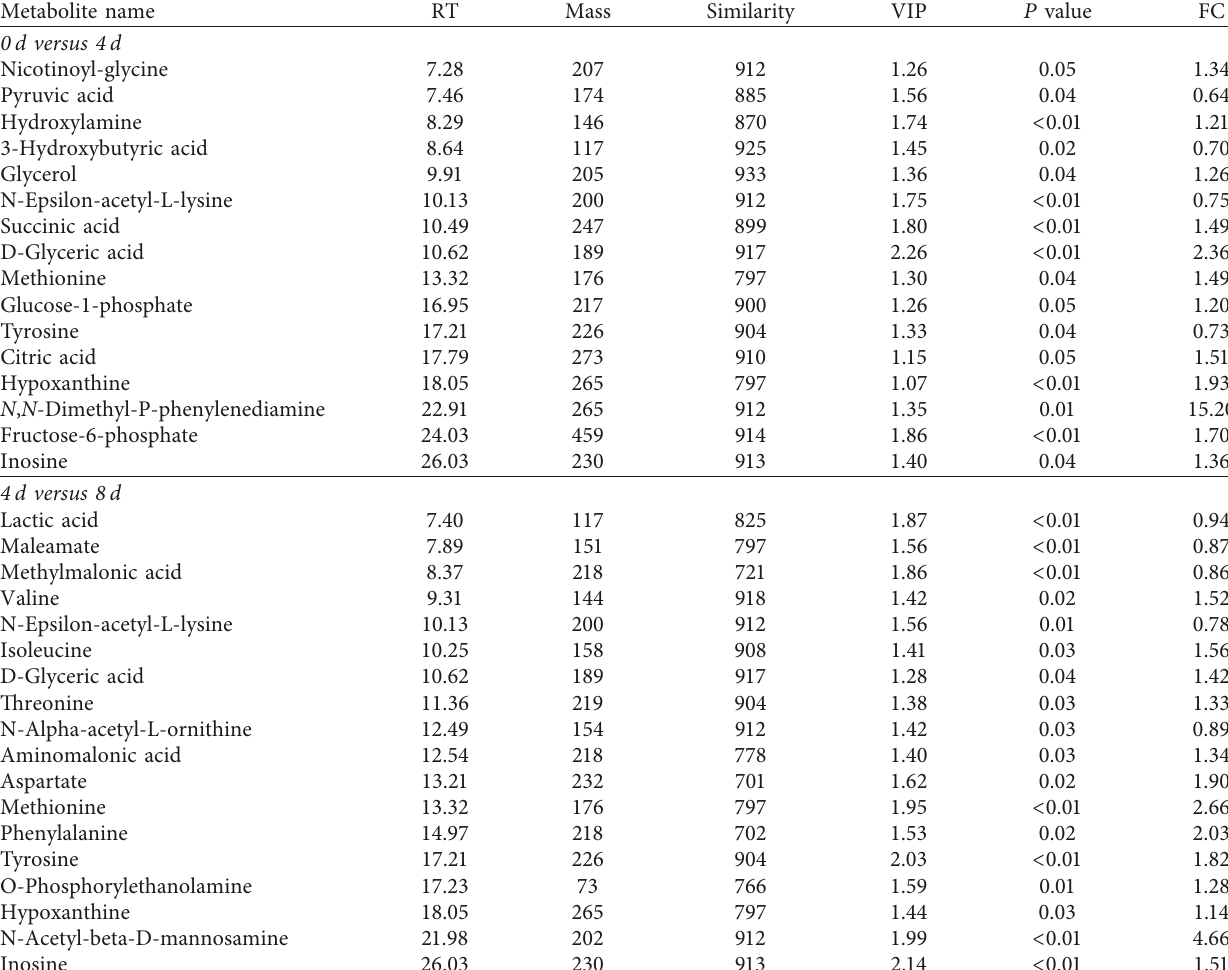
Table 1: Identification of significantly different metabolites in lamb samples using GC ×